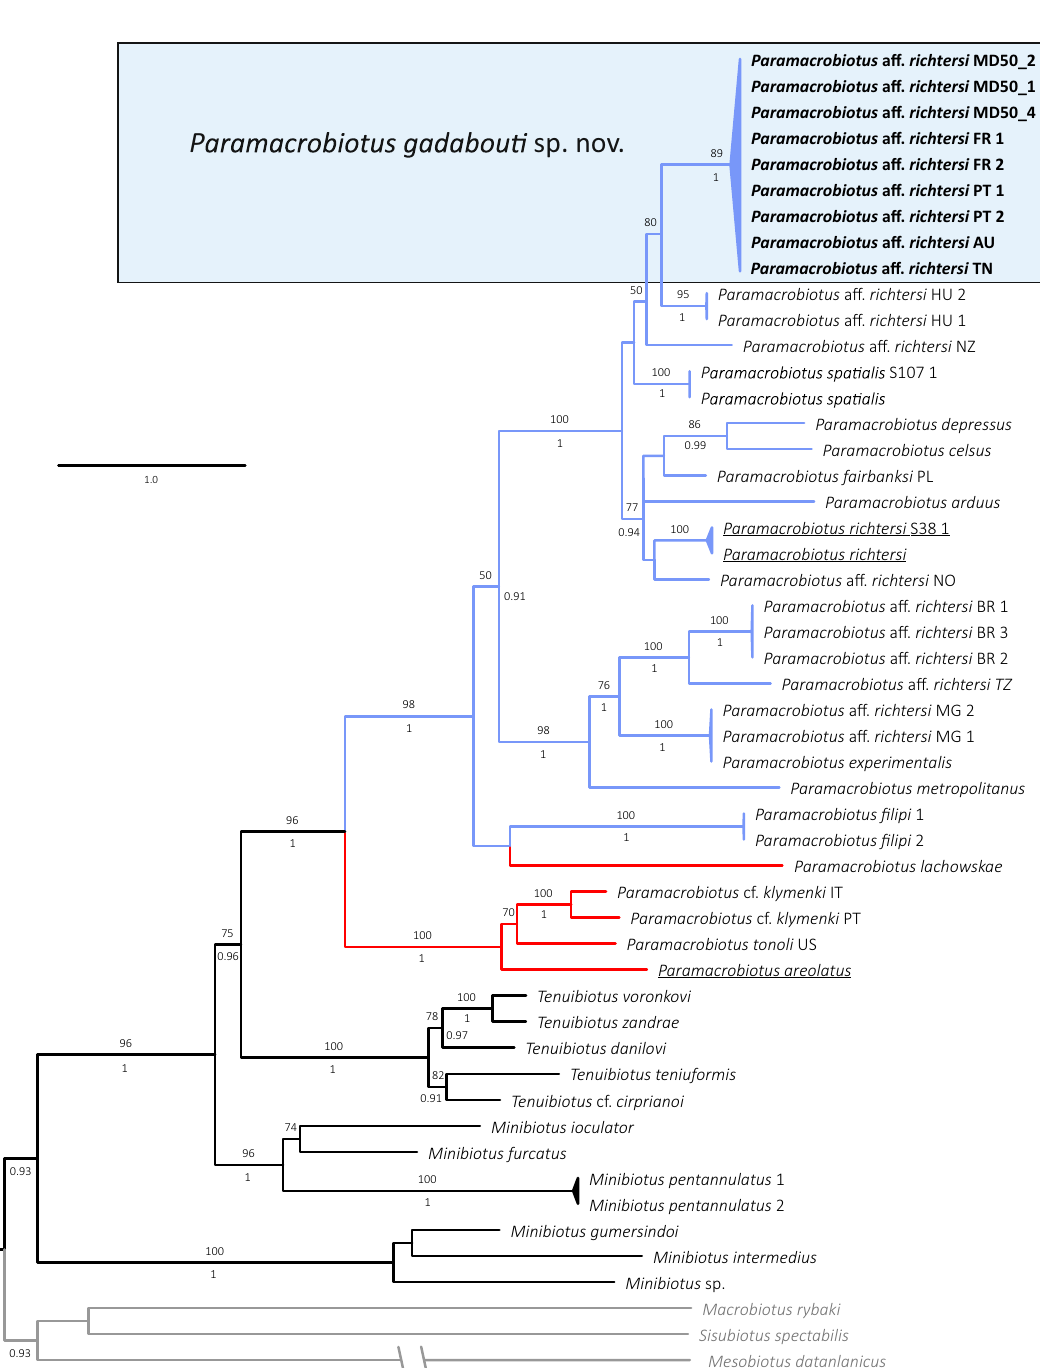
Australia and Tunisia as a single species (Fig. 1; SM.02) which is formally described below.